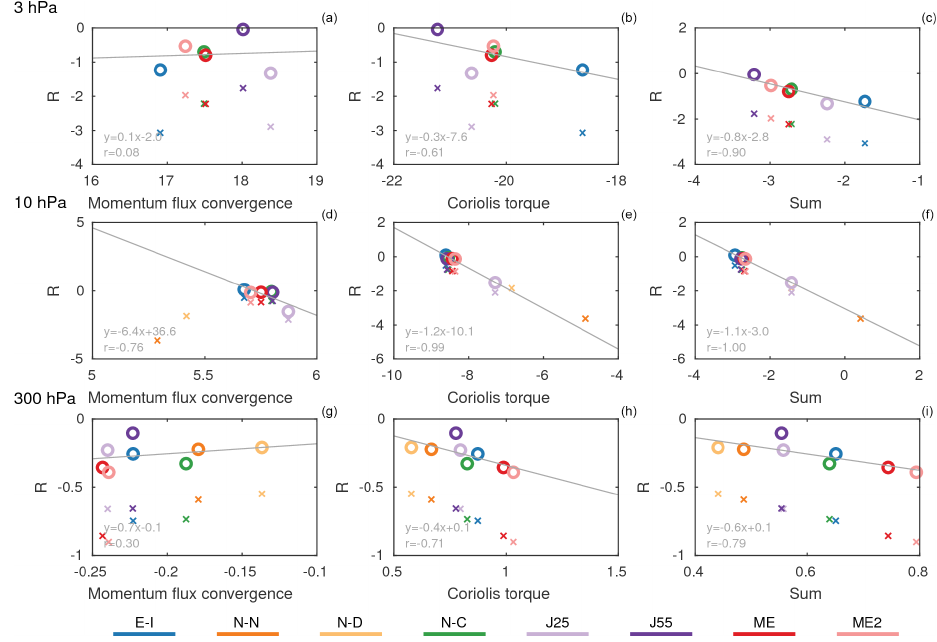
Figure 10. Scatterplot comparing the residual ( R ) with respect to (a, d, g) momentum flux convergence, (b, e, h) Coriolis torque, and (c, f, i) their sum. While R is shown with circles, R QG is shown using crosses. All variables are averaged between 45 and 85 ◦ N and from lag − 5 to 0 during SSW events. The (a–c) 3hPa, (d–f) 10hPa, and (g–i) 300hPa levels are shown. All variables are expressed in units of ms − 1 day − 1 . Linear regression of R with respect to each forcing term is displayed in each